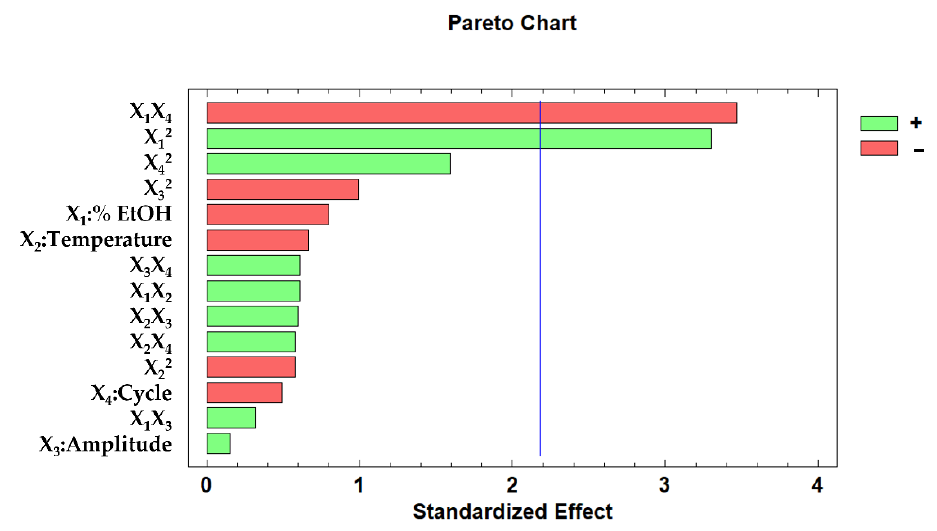
Figure 2. Pareto chart of the BBD–RSM analysis used to optimize the procedure for the extraction of betalains.